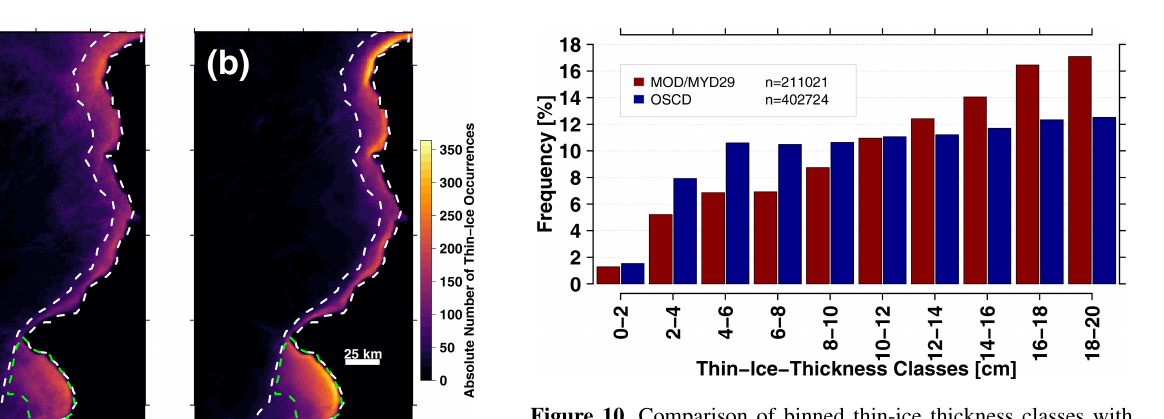
Figure 10. Comparison of binned thin-ice thickness classes with a bin size of 2cm based on all available swaths from 1 April to 30 September 2017 between the use of MOD/MYD29 (red) and OSCD (blue) data for the primary BIS polynya (green dashed out- line in Fig.